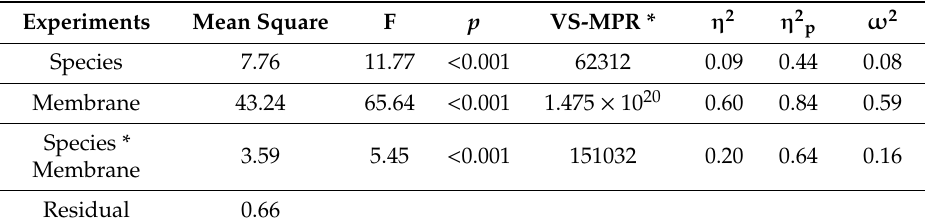
Table 5. Analysis of variance (ANOVA) of the antibacterial